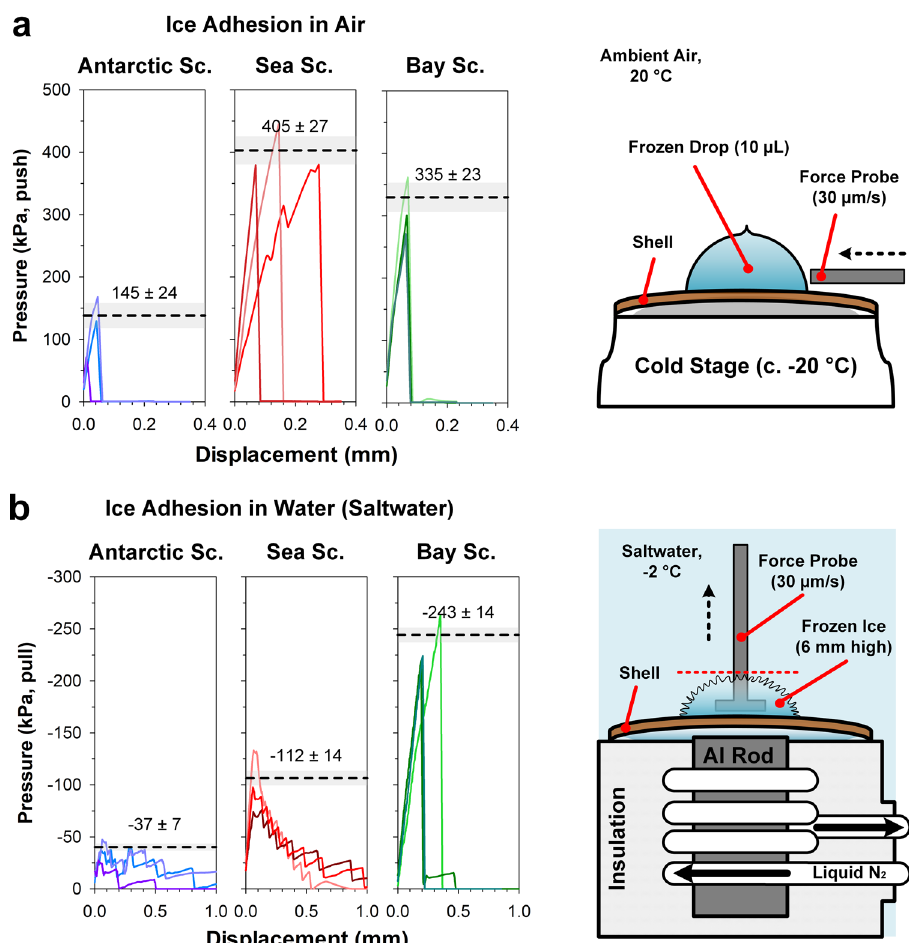
Fig. 5 Ice-adhesion measurements for Antarctic, Sea, and Bay scallops. a Displacement (lateral) of ice drops (10 µ L) from the surface of shells in a humidity-controlled chamber. Shell temperature: − 10 to − 15 °C (thickness-dependent). Peak force was achieved immediately before the complete detachment of the drop from the surface. b Displacement (normal) of accreted ice grown in simulated seawater at its freezing point (35 g/L NaCl, c. − 2 °C). Mean peak recorded force (dashed lines) ±1 SE (shaded areas) for three repetitions of each experiment are shown. Experimental details are available in the Supplementary Methods and